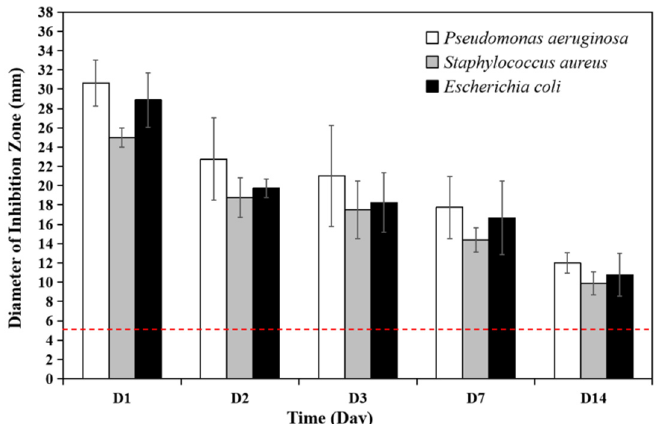
Figure 3. Anti-microbial activities of gentamicin loaded PMMA bone cements were presented by bacterial inhibition zone assay for Pseudomonas aeruginosa , Staphylococcus aureus and Escherichia coli . The dashed line indicates 5 mm, the diameter of the bone cement disc. Table 3. Measurements (in mm) of the zones of inhibition with bone cements containing gentamicin. Bacteria